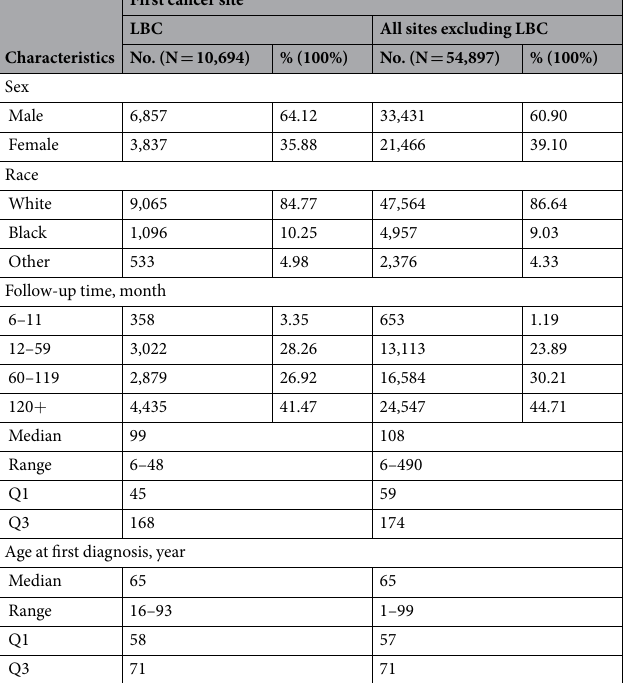
SPCs after LBC in female patients